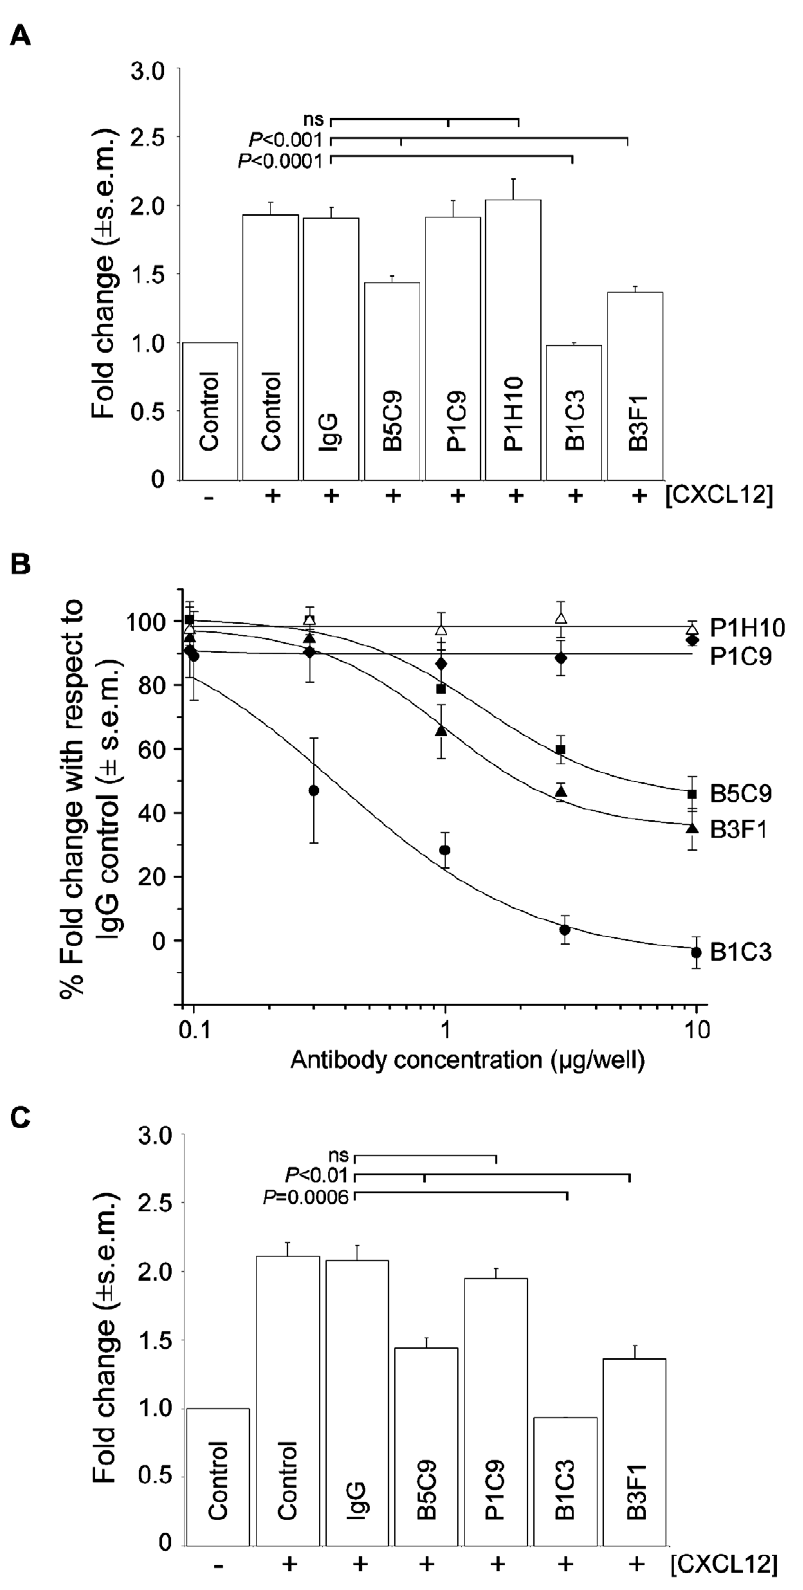
Figure 9. Inhibition of chemotaxis by monoclonal antibodies recognizing 5T4. (A), The chemotactic migration exhibited by differentiating WT-ES cells towards CXCL12 was abolished in the presence of the m5T4 specific mAb B1C3 (10 m g) but not in presence of mAb P1C9 or P1H10 (10 m g) or an irrelevant control antibody (10 m g). MAbs B3F1 and B5C9 (10 m g) reduced the chemotactic response. ( 2 = no CXCL12, + = 10ng